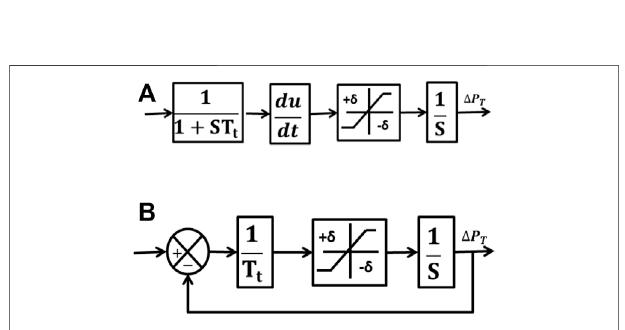
FIGURE 3 | GRC structure. (A) Open-loop and (B)